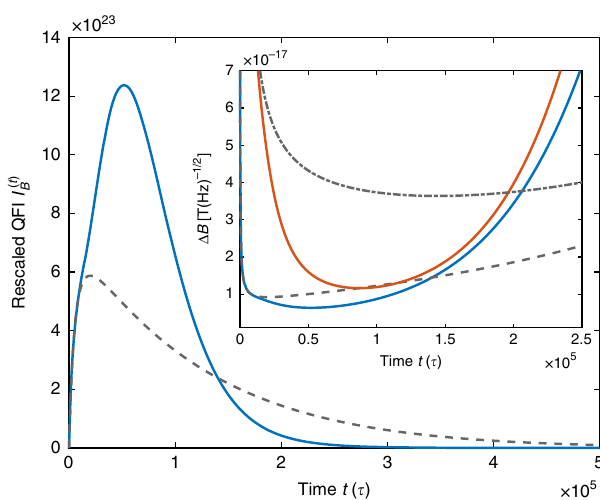
Fig. 9 Performance of a magnetic- fi eld measurement with a kicked atomic- vapor magnetometer. While the gray dashed line shows the rescaled quantum Fisher information I t ð Þ B for measuring the magnetic fi eld B with an spin-exchange-relaxation-free magnetometer, the blue line is obtained by adding a short optical kick at the end of each period τ . The inset shows ffiffiffiffiffiffi p precision Δ B in units of T per for an optimal measurement (gray Hz dashed line and blue line without and with kicks, respectively) and for measuring the z -component of the electronic spin S z (gray dash-dotted and red line without and with kicks,